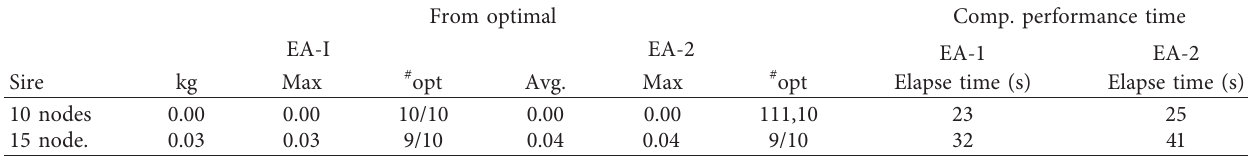
Table 1: Comparison of EA1 and EA2 to optimal solutions. From optimal